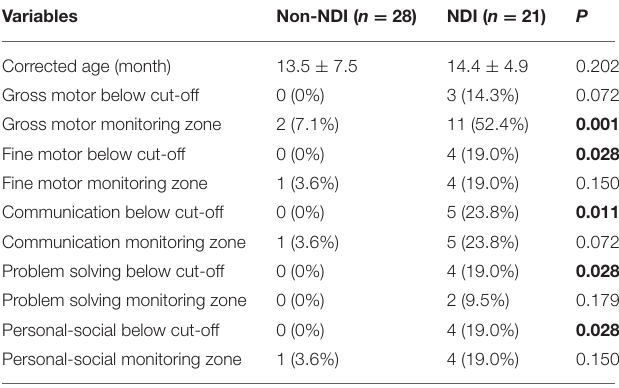
TABLE 3 | Results of Ages and Stages Questionnaire (v.3) assessment in neurodevelopmental impairment (NDI) and non-NDI